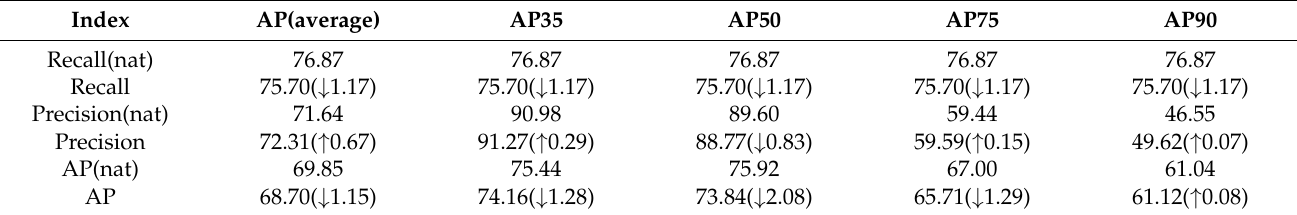
Table 3. The detection performance of the YOLOv3 without our defense algorithm on clean images, and the detection performance of the YOLOv3 with our defense algorithm under the adversarial patch attack.